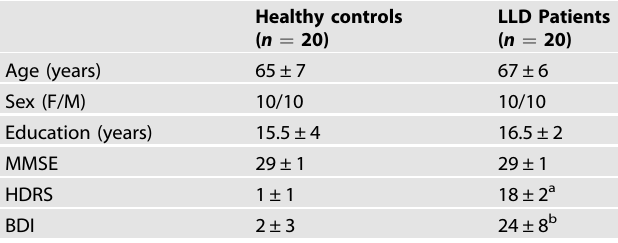
Table 1. Demographic and clinical characteristics of the late-life depressed (LLD) patients and